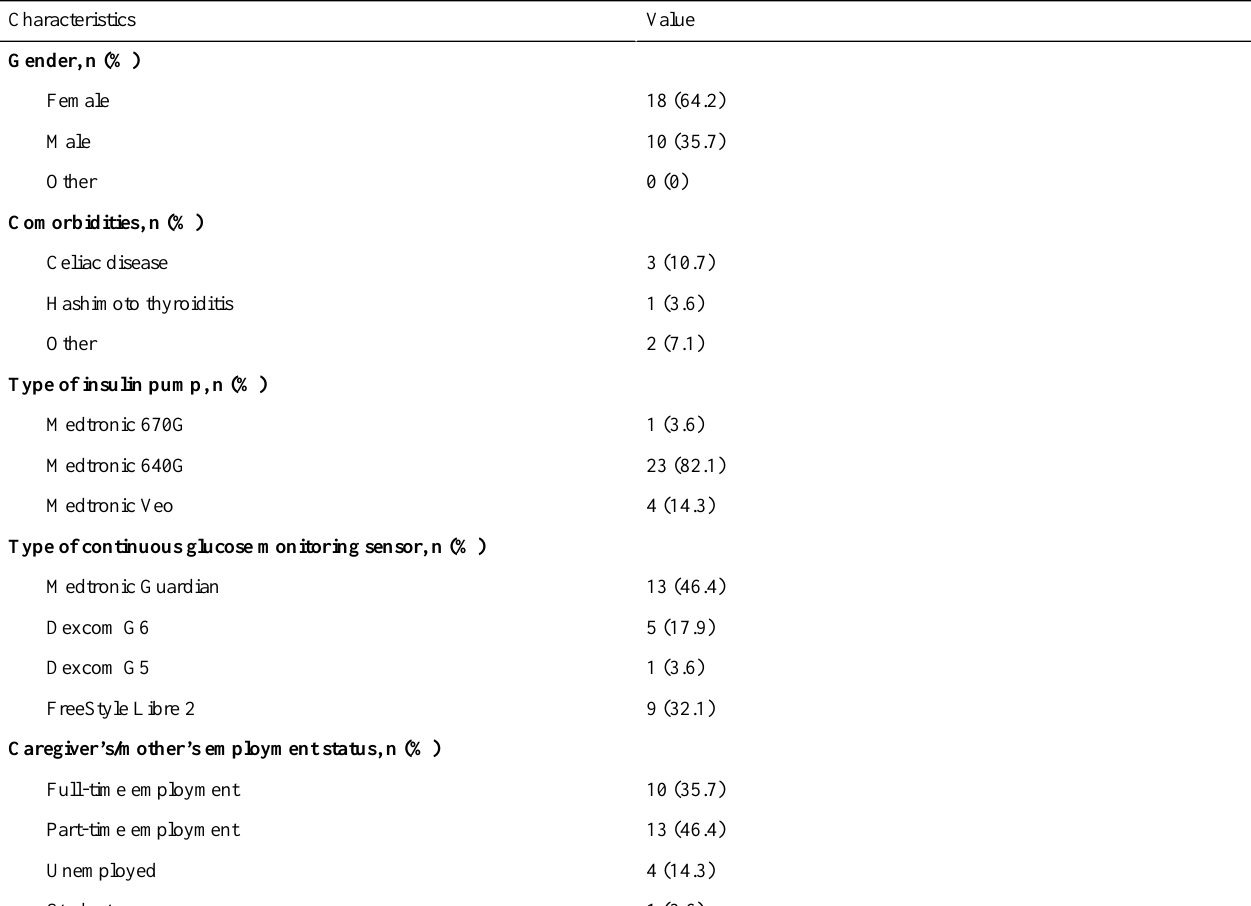
Table 1. Sociodemographic characteristics of the study